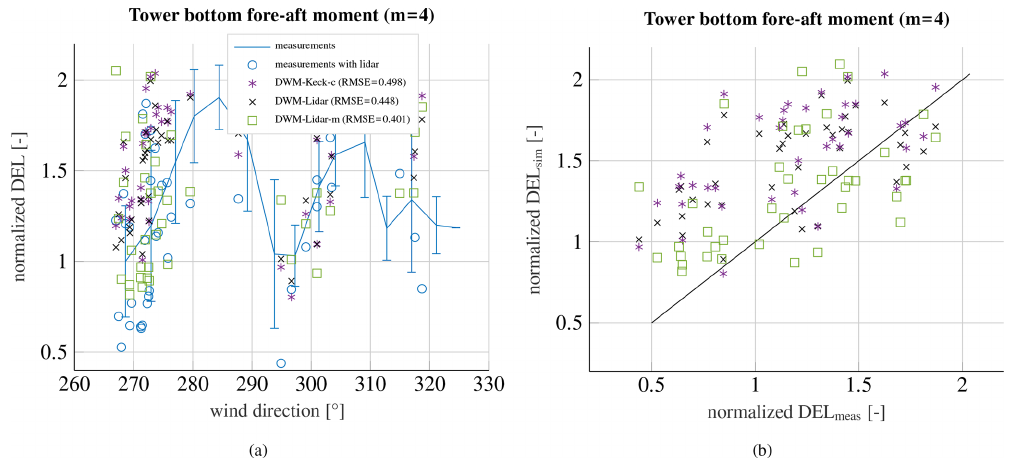
Figure 17. Measured and simulated tower bottom fore-aft bending moment over the wind direction (a) and simulated loads over measured loads (b) at an ambient wind speed of 8ms − 1 and an ambient turbulence intensity of 10%, when WTG 2 is exposed to the wake of WTG